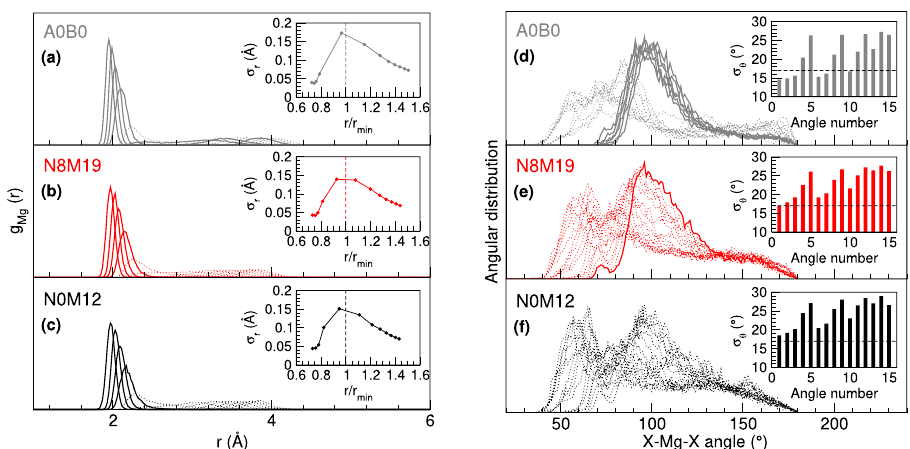
Fig. 6 Comparison of the radial and angular environment around magnesium for three different type of magnesium-containing glasses. Dashed lines correspond to a large distribution of environments. Insets ( a – c ) display the mean radial excursion value of the 12 nearest neighbors as a function of a their distance to the considered element, rescaled by the minimum value of the partial pair correlation r min , while inset for ( d – f ) corresponds to angular excursion relative to each of the 15 angles for a given element. Dashed lines in insets correspond to the limit between active and broken angular constraints, as based on literature.